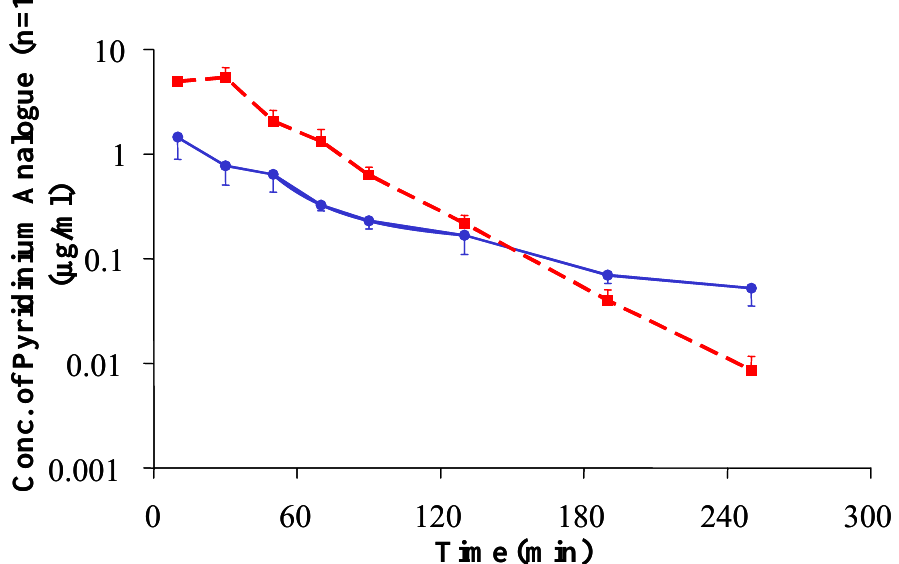
Figure 7 . Concentration of the [pyridinium 2 ]TRH analogue with n=1 (i.p. injection of its prodrug at a dose of 15 mg/kg body weight) in the hippocampus (circles, blue solid line) and in blood (squares, red dashed line) of rats, measured via in vivo microdialysis sampling followed by LC/ESI-MS/MS assay. Reprinted with permission from [63]. © 2004 American Chemical